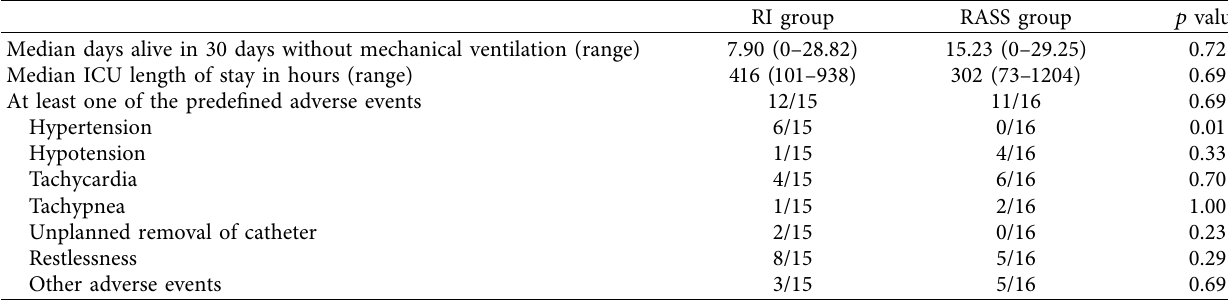
Table 2: Outcome and adverse event data.